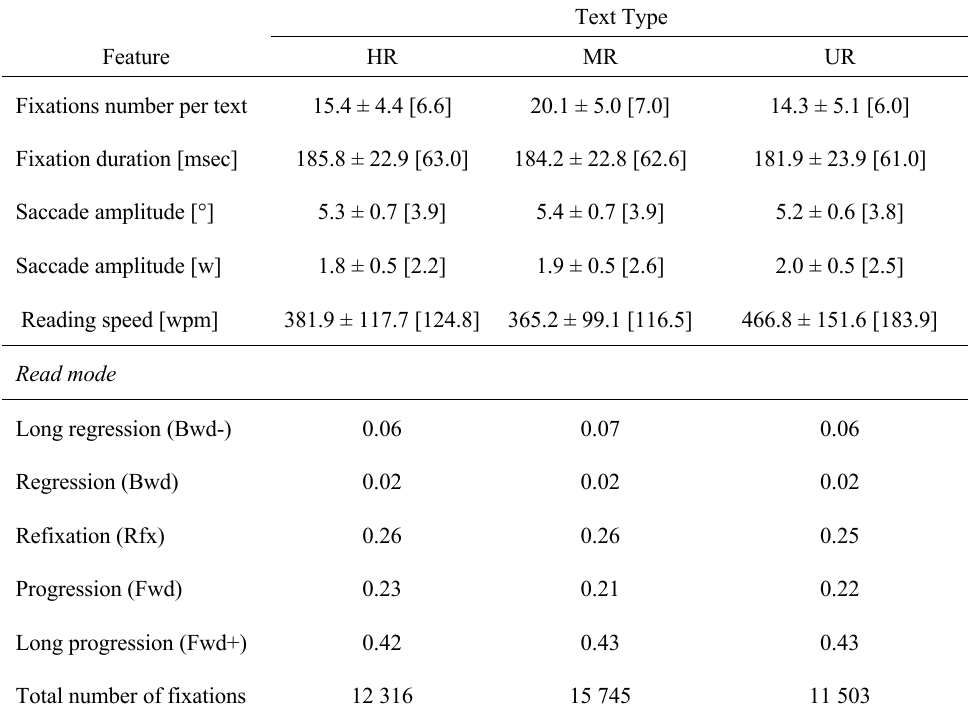
Table 2. Average ± between-participant standard deviation [within-participant standard deviation] for the number of fixations per text, the fixation duration, the saccade amplitude expressed in degree [°] and in number of words [w], and the reading speed [wpm] depend- ing of the type of text, followed by Read mode frequencies and total number of fixations per text